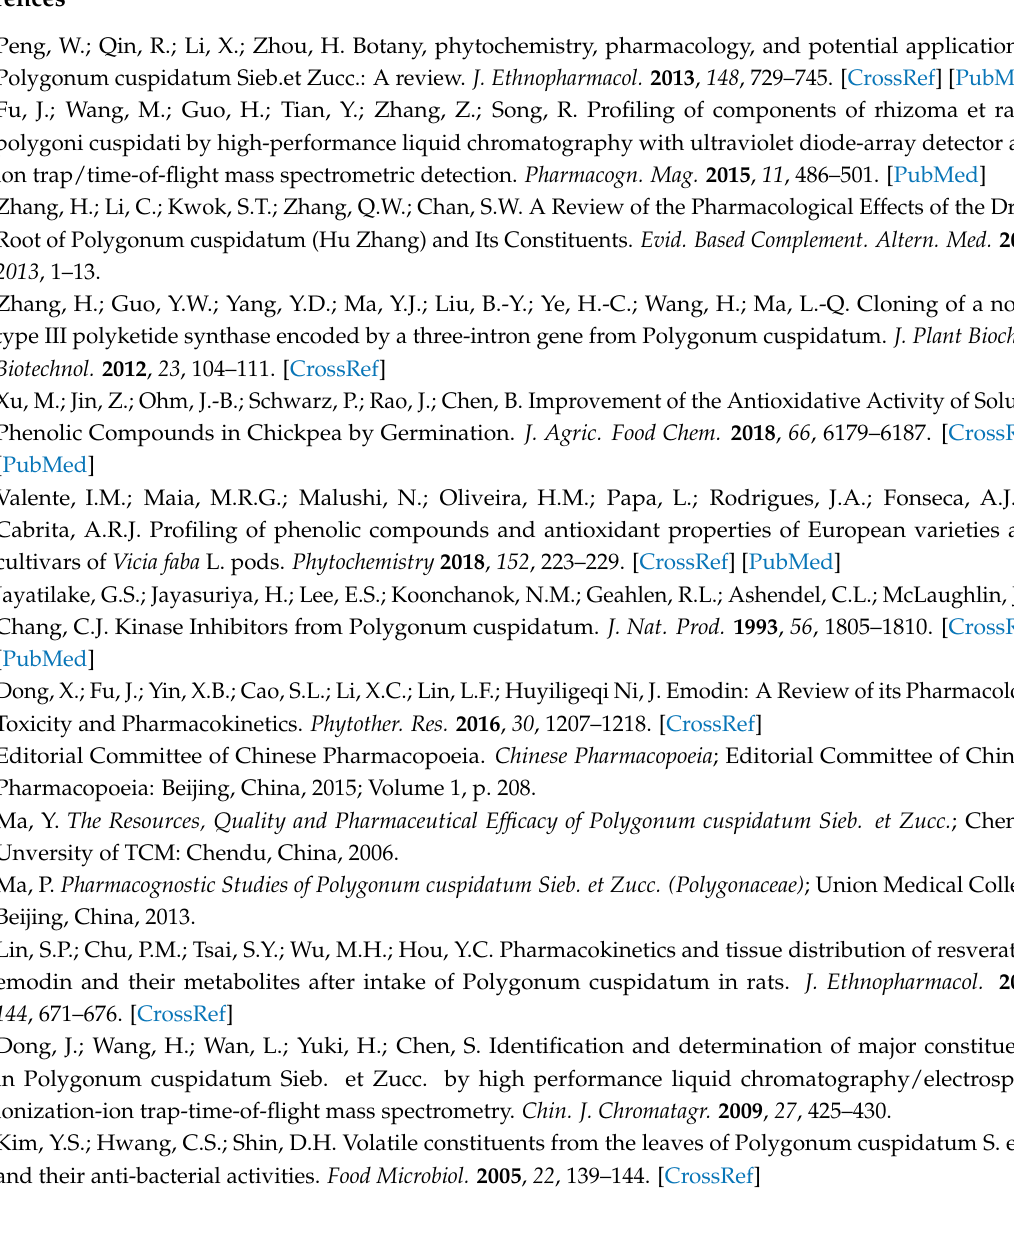
Supplementary Materials: The following are available online. Figure S1: Typical LC-MS extracted ion chromatograms of metabolites that extracted from different